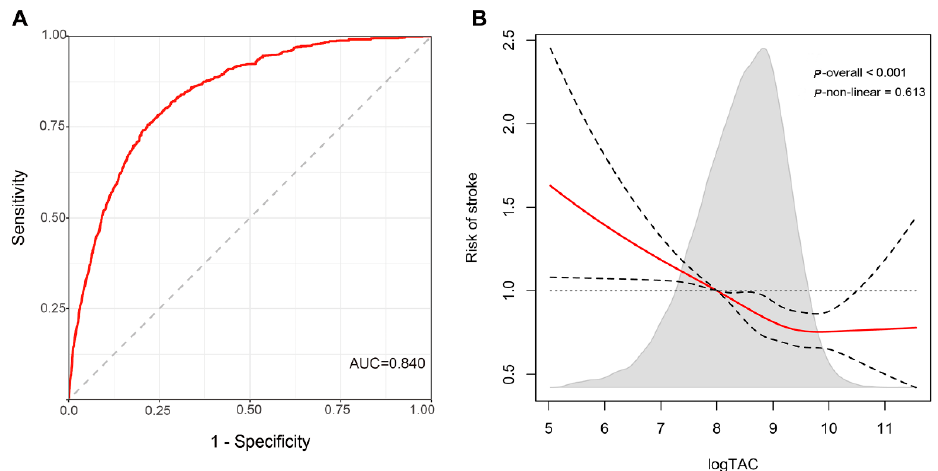
Figure 2. ROC curve and restricted cubic spline plot for the relationship between total antioxidant capacity and the risk of stroke among US adults. ( A ) Survey-weighted ROC curve for the relationship between total antioxidant capacity and the risk of stroke. The ROC curve was adjusted for age, gender, race, alcohol, smoke, activity, diabetes, hypertension, dyslipidemia, CVD, BMI and NLR. CVD: cardiovascular disease; BMI: body mass index; NLR: neutrophil to lymphocyte ratio. ( B ) Restricted cubic spline plot for the relationship between total antioxidant capacity and the risk of stroke. ORs were adjusted for age, gender, race, alcohol, smoke, activity, diabetes, hypertension, dyslipidemia, CVD, BMI and NLR. TAC was log-transformed and the shaded area was the distribution of TAC. A logTAC level of 8 was used as the reference to estimate all ORs. The dashed areas indicate the 95% CI. CVD: cardiovascular disease; BMI: body mass index; NLR: neutrophil to lymphocyte ratio; TAC: total antioxidant capacity.